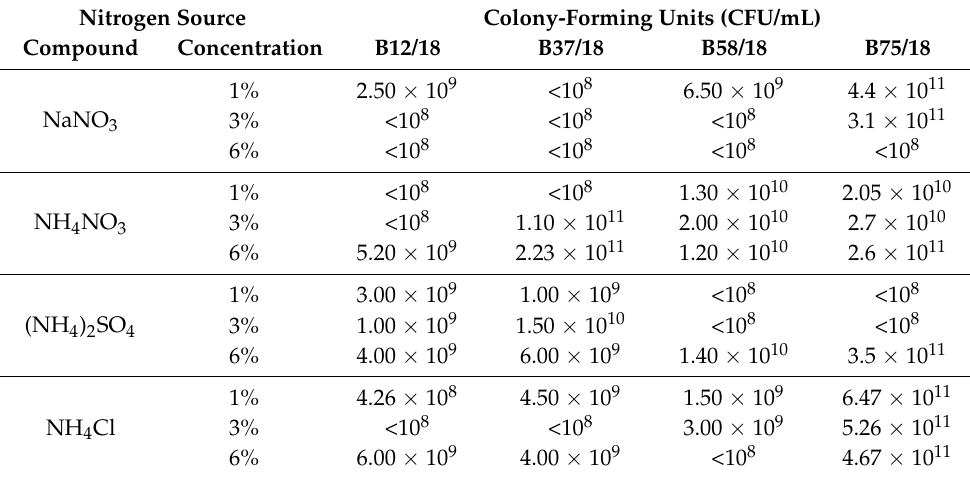
Table 2. The effect of different nitrogen sources (NaNO 3 , NH 4 NO 3 , (NH 4 ) 2 SO 4 , NH 4 Cl) and their concentrations of 1%, 3%, 6%, on the growth of bacteria in a liquid culture. Rhodococcus sp. B12/18, Pseudomonas sp. B37/18, Arthrobacter sp. B58/18, and Rhodococcus sp. B75/18, pH = 7.2, culturing temperature = 30 ◦ C. Nitrogen Source Colony-Forming Units (CFU/mL)